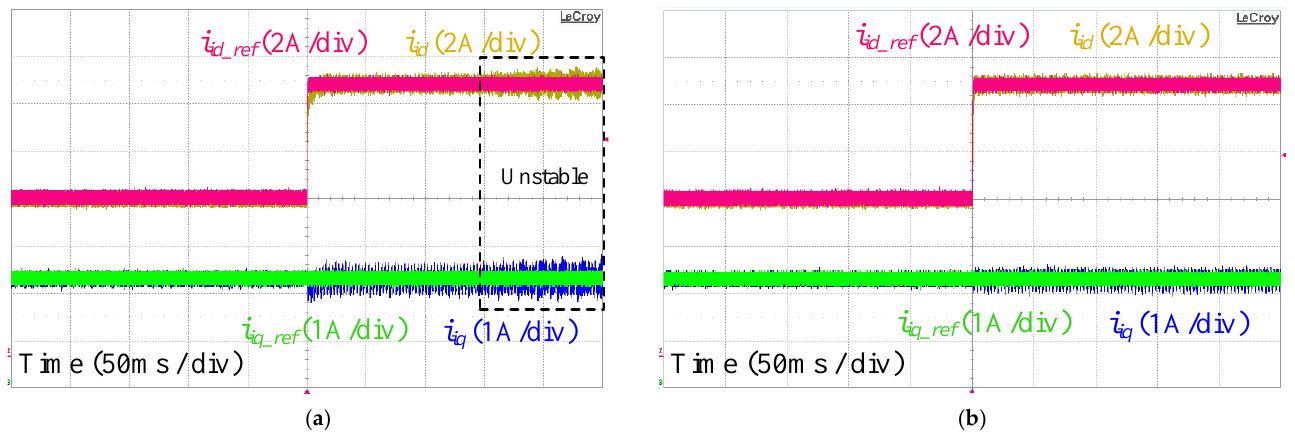
Figure 22. Current tracking of i id and i iq with C fk = 0.5 μF ( a ) Single-loop PI control; ( b ) RESO-based ADRC.